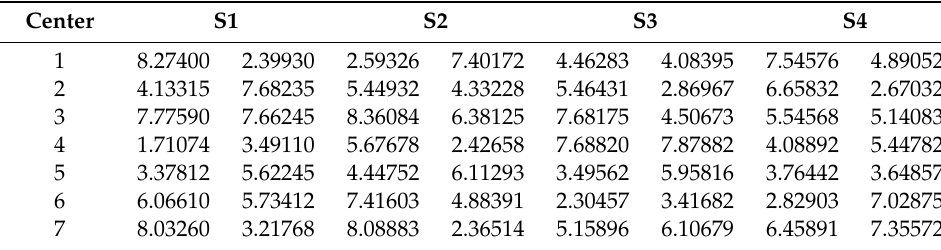
Table 5. Cluster centers of the K-Means cluster algorithm.